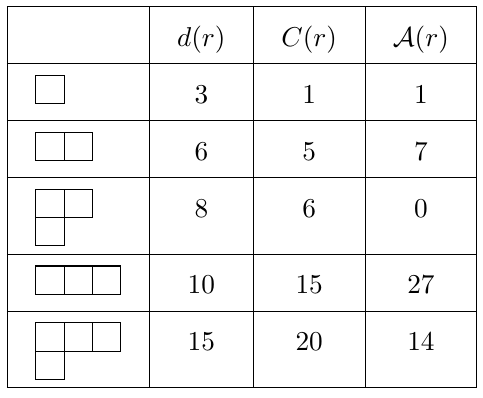
Table 6 . Properties for some representations of SU(3) . Note that the 8 is the